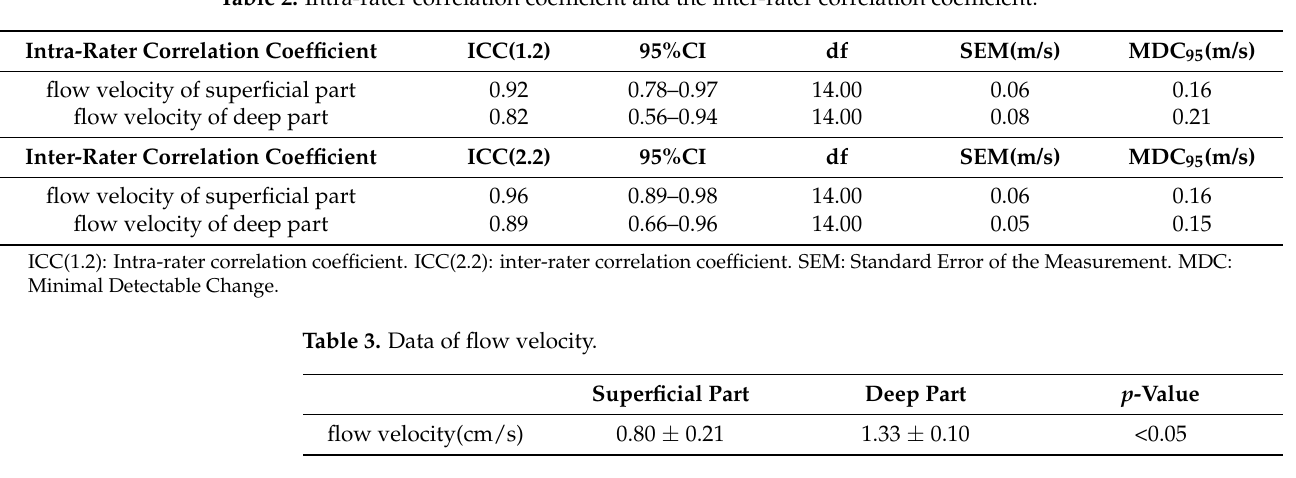
Table 2. Intra-rater correlation coefficient and the inter-rater correlation coefficient.